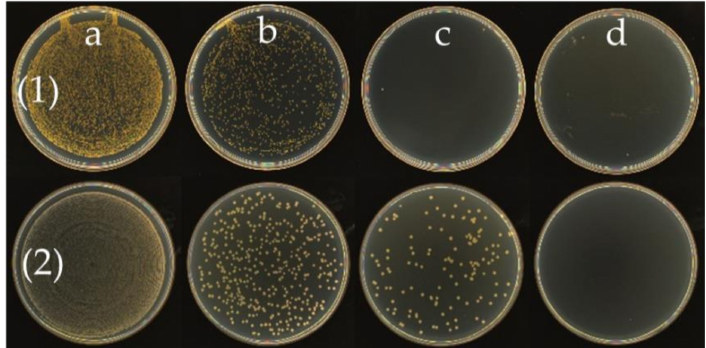
Figure 8. Antibacterial performance of octyl-QDED. Bacteria: (1) S. aureus , (2) E. coli ; octyl-QDED concentration: ( a ) 1 µ g / mL, ( b ) 2 µ g / mL, ( c ) 4 µ g / mL, ( d ) 8 µ g / mL.